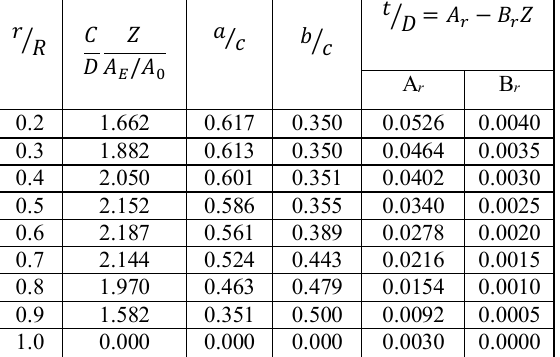
Table 1. Main geometrical characteristics of the profiles for four, five, six and seven blades,